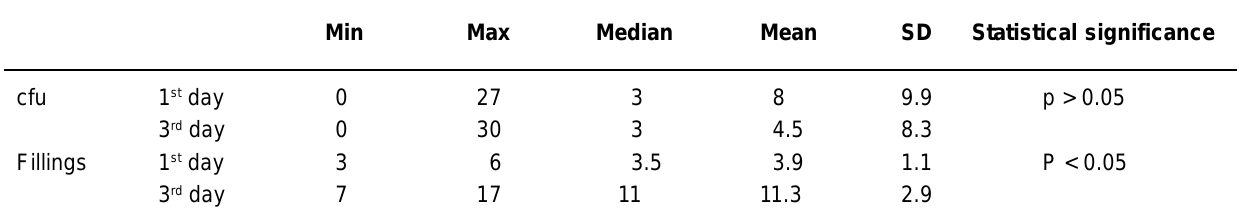
TABLE 2- Descriptive statistics for the first and the third day variables (cfu: colony forming units of microorganisms, and root canal fillings) and statistical significance of the differences between these values